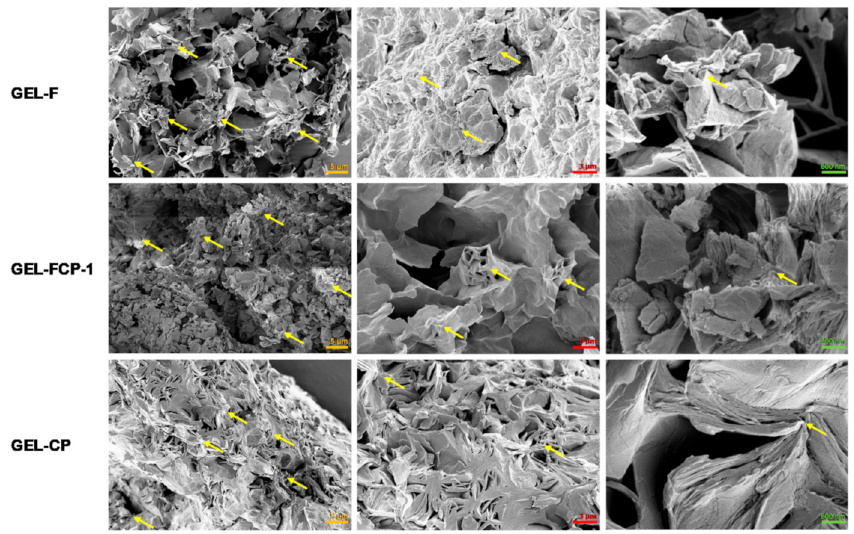
Figure 3. FE-SEM (field-emission scanning electron microscopy) micrographs of the microstructure of each samples. Yellow arrows indicate the aggregation zone consist of a firmed 3D structure formed by α -CD/mPEG and α -CD/PEO by host-guest reaction.